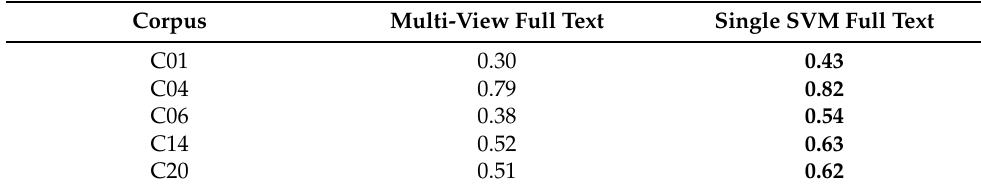
Table 5. Kappa values obtained by the base